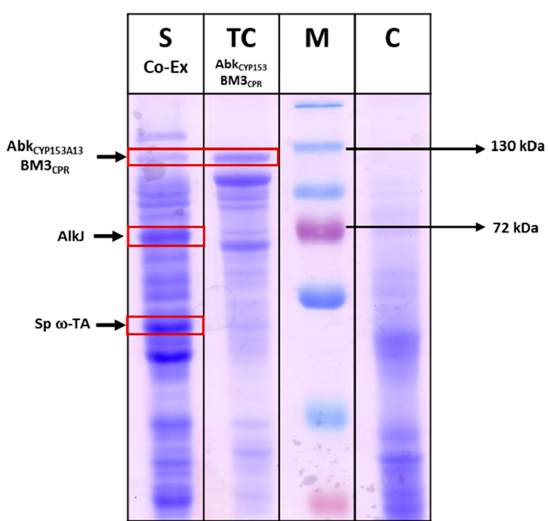
Figure 4. SDS-PAGE analysis of recombinant E. coli expressing Abk CYP153A13 BM3 CPR (~120 kDa), AlkJ